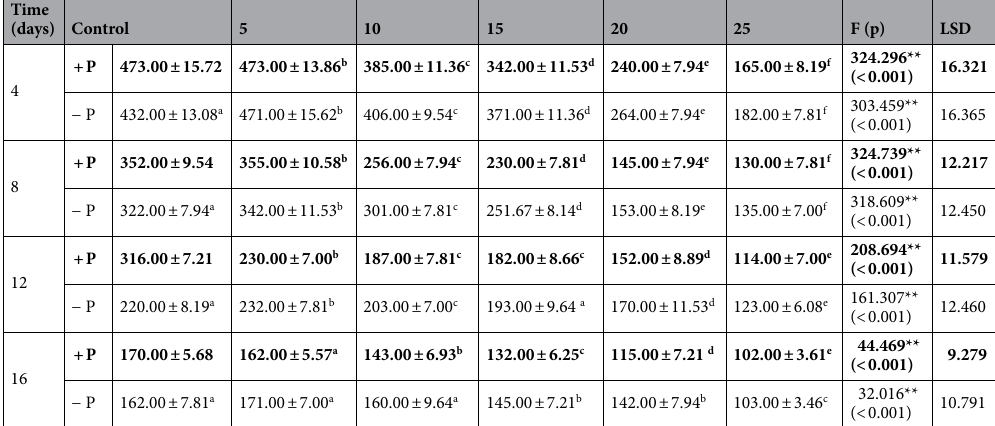
Table 3. Effect of different concentrations of dissolved nickel (mg/L) on photosynthetic activity (O 2 -evolution calculated as µ mol O 2 mg chl -1 h -1 ) on phosphorus supplemented and starved cells of Dunaliella tertiolecta . F F test (ANOVA). Least significance difference at 0.05. *Statistically significant at p ≤ 0.05. **Statistically significant at p ≤ 0.001. Different superscripts are